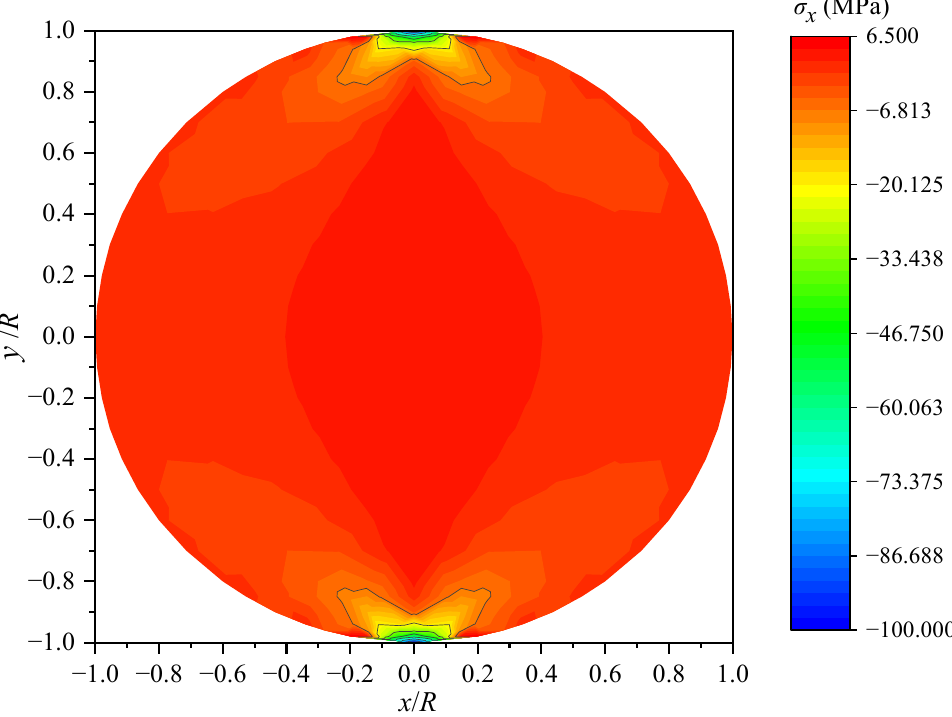
Figure 4. σ x contour map of the axial compression on the part boundary of the circular shaft.